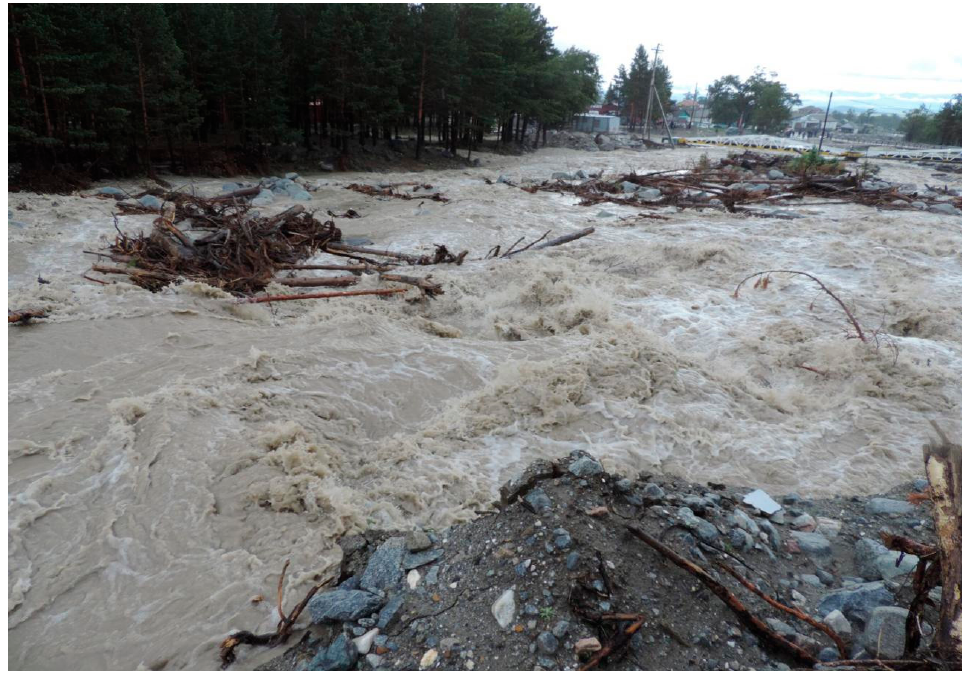
Figure 14. Water-rock flow on the Kyngarga river at the July 14, 2015 peak maximum, time: 11:45.